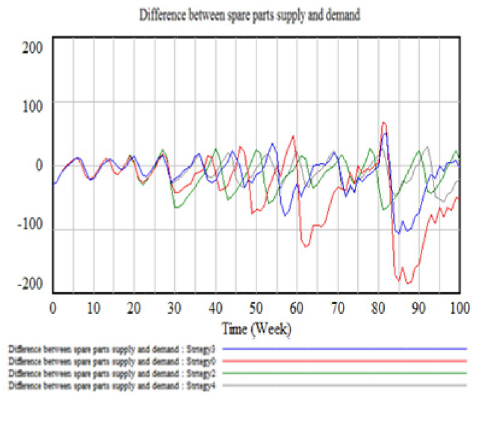
Figure 14.Difference between spare parts supply and demand